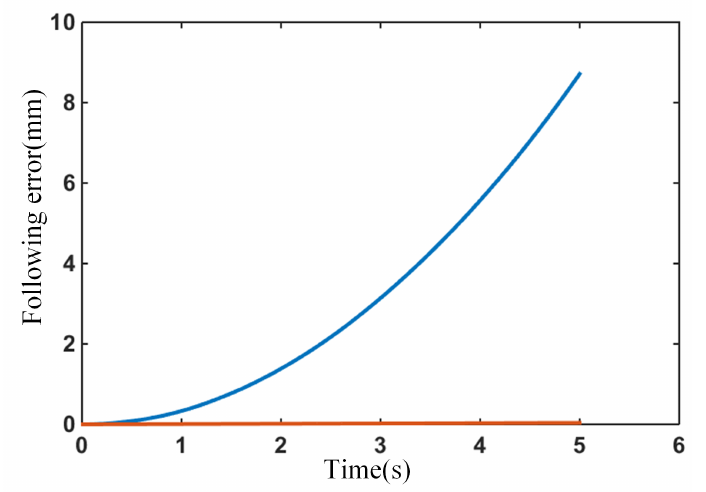
Figure 11. Comparison of following error with (red line) and without (blue line) error feedback